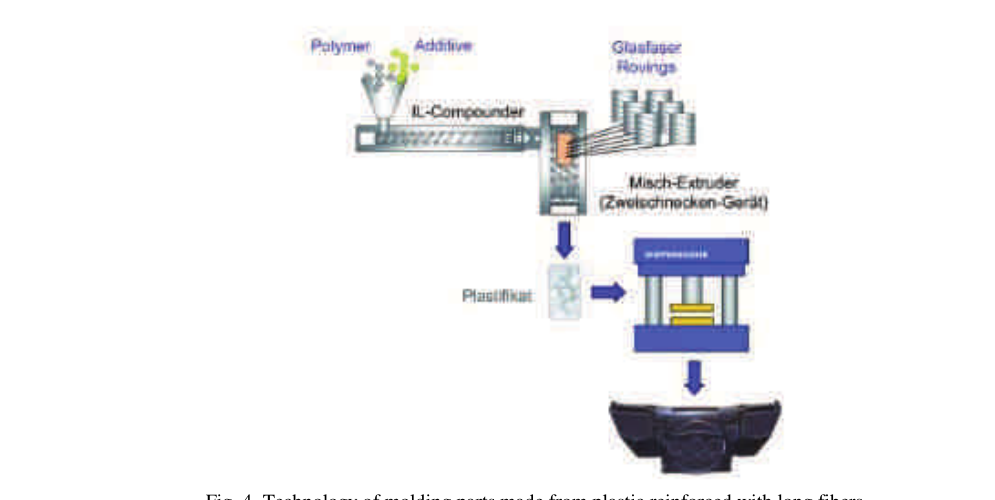
Fig. 4. Technology of molding parts made from plastic reinforced with long